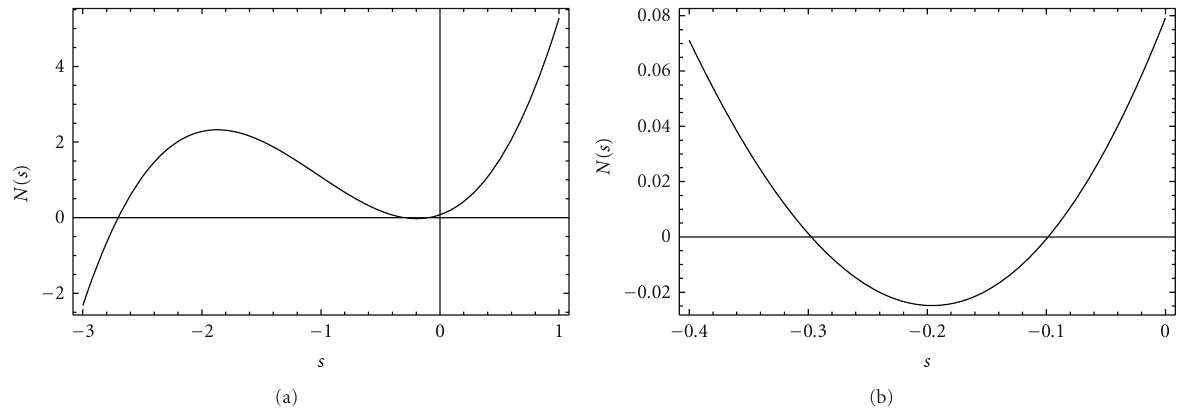
Figure 2: Characteristic function N ( s ). The right-hand figure shows the two largest roots of the equation. of e − ω 1 t , e − ω 2 t and e − ω 3 t . As an illustration, we give the expectation m ( F ) ( t | F ) of the number of fast neutrons, 1 generated by one initial fast neutron injected into the